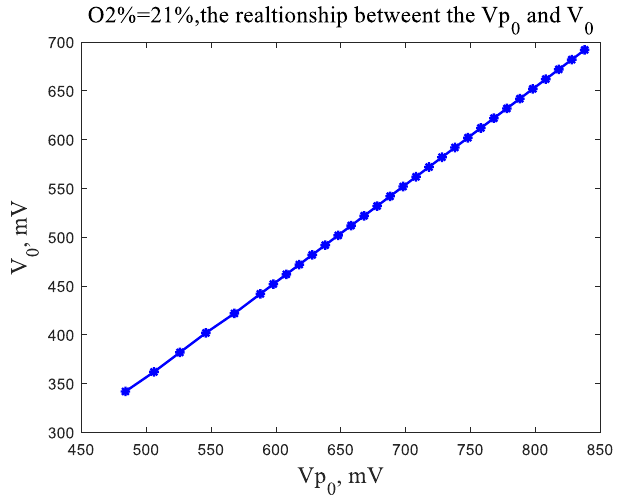
Figure 10. The relationship between the V 0 and Ip 1 .